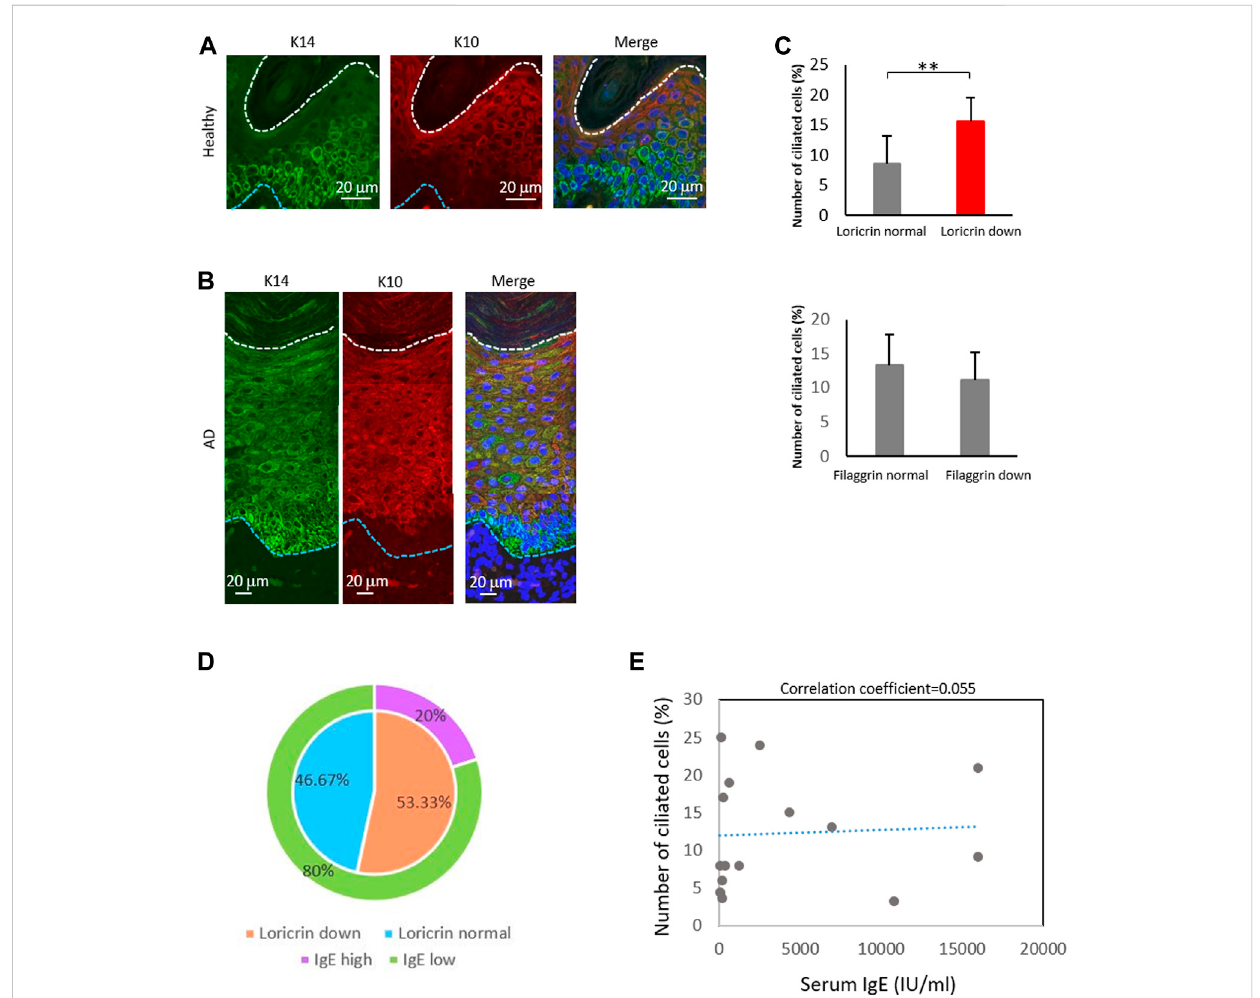
FIGURE 5 The percentage of ciliated cells correlates with loricrin expression. (A and B) Immunostaining of K14 (green) and K10 (red) in (A) healthy epidermis, and in (B) atopic epidermis. The blue dotted line indicates the basal membrane. The white dotted line indicates the stratum corneum. Three biological replicates (3 donors) were examined. Scale bar: 20 μ m. (C) Correlation between the number of primary ciliated cells and the epidermal barrier proteins loricrin (top) and fi laggrin (bottom). AD epidermis samples derived from 15 patients were immunostained with either loricrin or fi laggrin, with acetylated tubulin. Patients were classi fi ed into 2 groups based on the expression level of barrier proteins. The average percentages of primary ciliated cellsinbothgroupswerecalculated.**, p < 0.01(Student ’ st-test). (D) ThepercentageofADpatientsshowingloricrinnormal,loricrinlow,IgElow,andIgE high. n = 15 donors. (E) Correlation between the number of ciliated cells and the serum IgE level in AD patients. n = 15